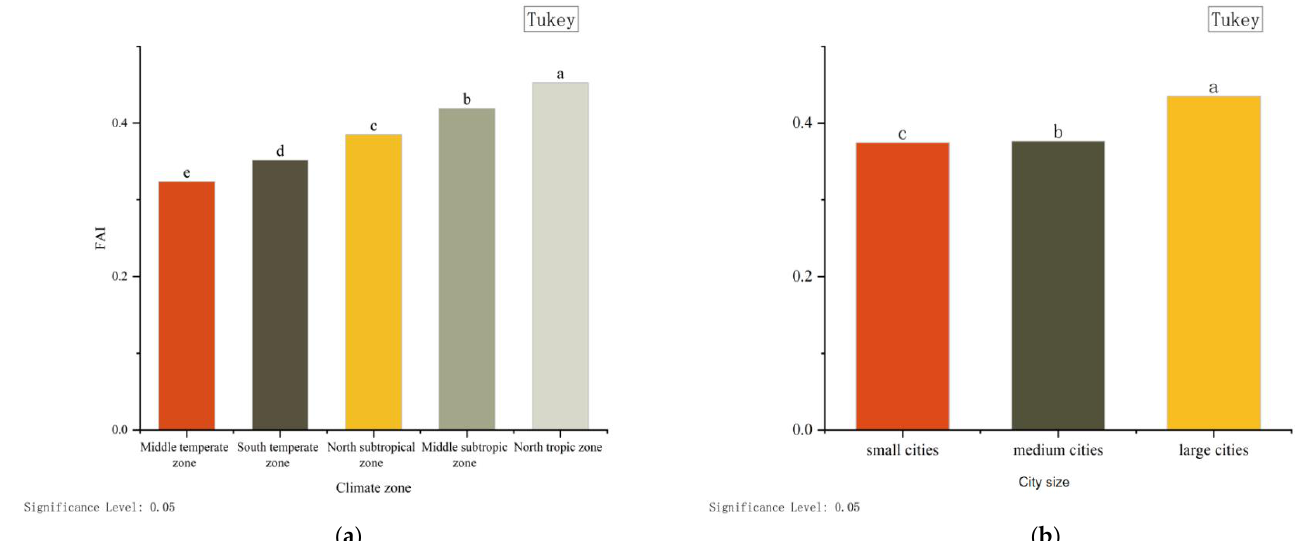
Figure 5. Tukey’s multiple comparisons of FAI in different cities. The figure uses letters on different bar charts to show differences. If the letters on two bars that are the same, there is no difference between them, whereas if the letters are different, there is a difference. ( a ) Cities in different climate zones; ( b ) cities of different sizes.